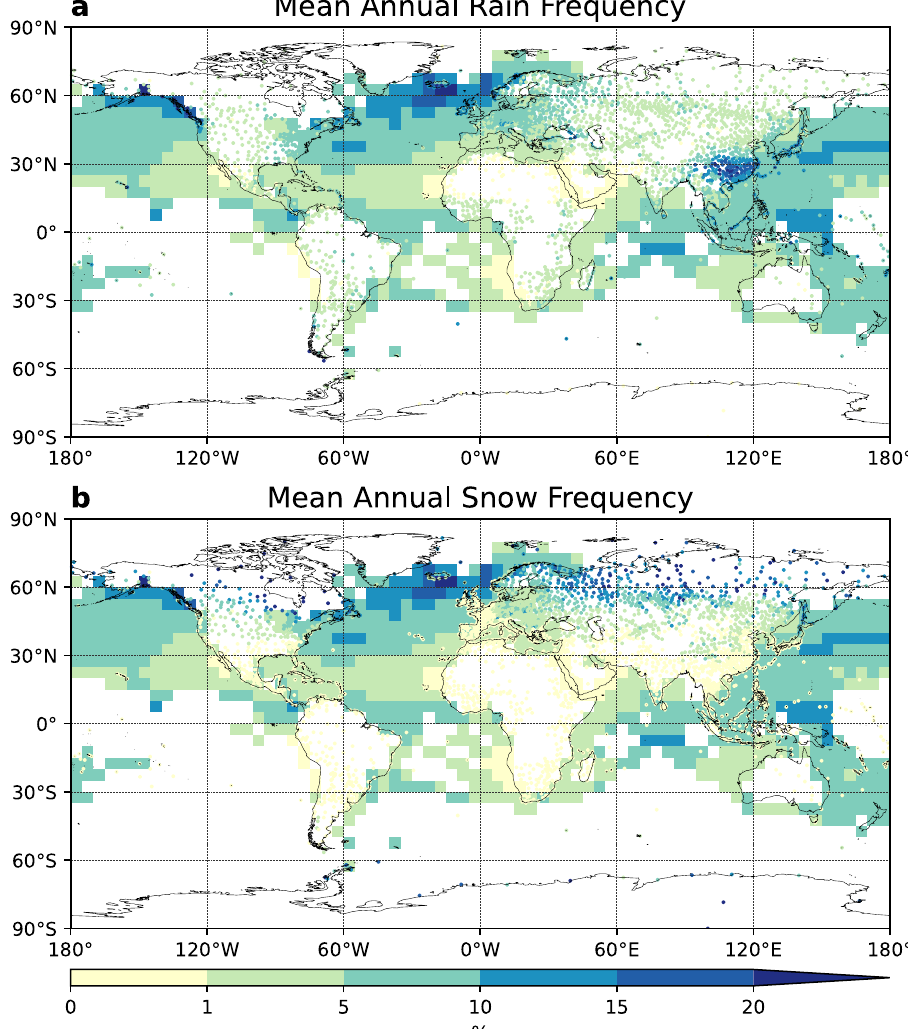
Figure 2. Mean annual rain and snow frequency of occurrences. ( a ) Mean annual rain frequency. ( b ) Mean annual snow frequency. Rain (snow) frequency of occurrence was calculated for each year, then the 42-year mean were computed for 1978–2019. This figure was plotted using Python 3.7.4 (https:// www. python. org/ downl oads/ relea se/ python-